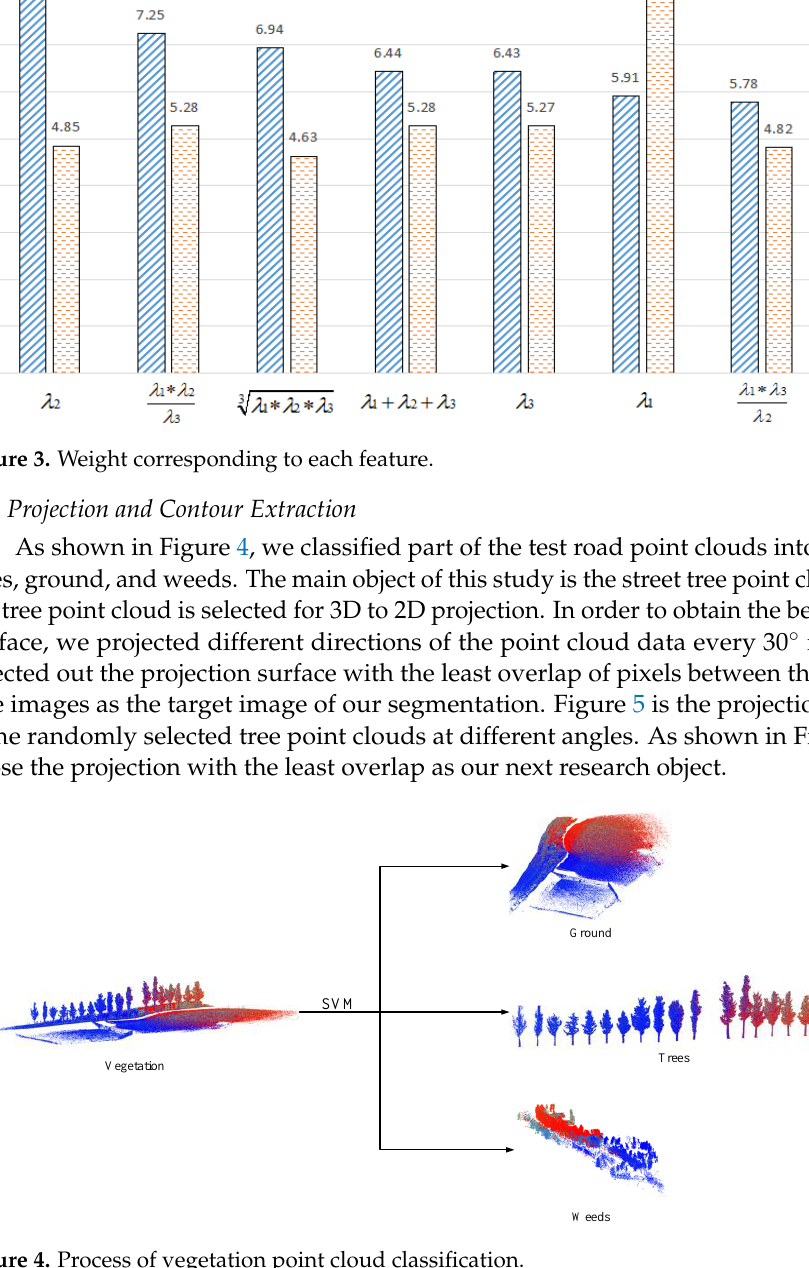
Figure 4. Process of vegetation point cloud classification.